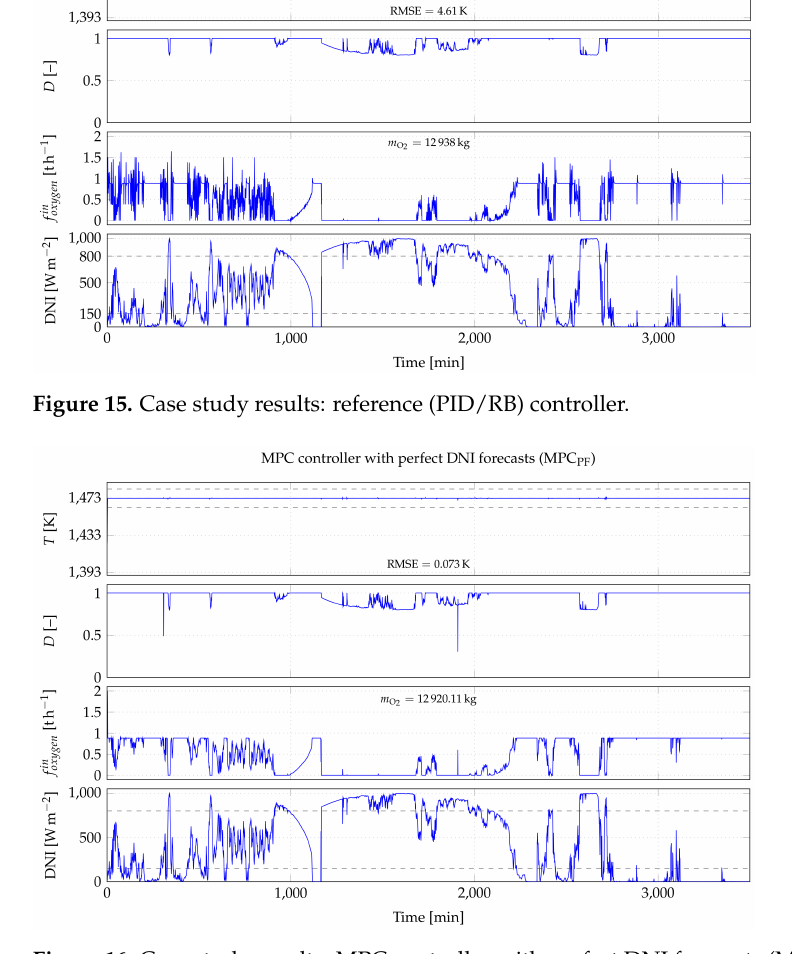
Figure 16. Case study results: MPC controller with perfect DNI forecasts (MPC PF ). The prediction horizon of the controller is